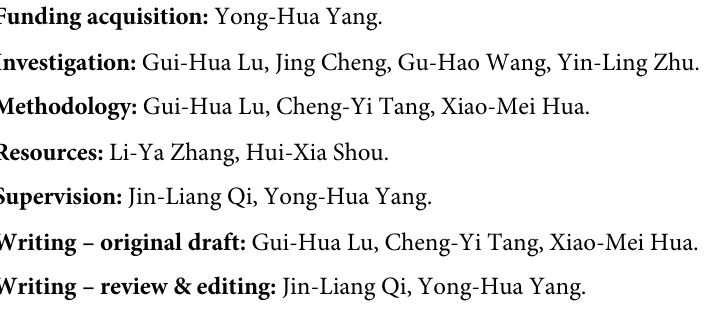
S28 Table. Relative abundances of bacterial genera at the flowering stage. S29 Table. Relative abundances of bacterial genera at the seed-filling stage. S30 Table. Relative abundances of bacterial classes at the flowering stage. S31 Table. Relative abundances of bacterial classes at the seed-filling